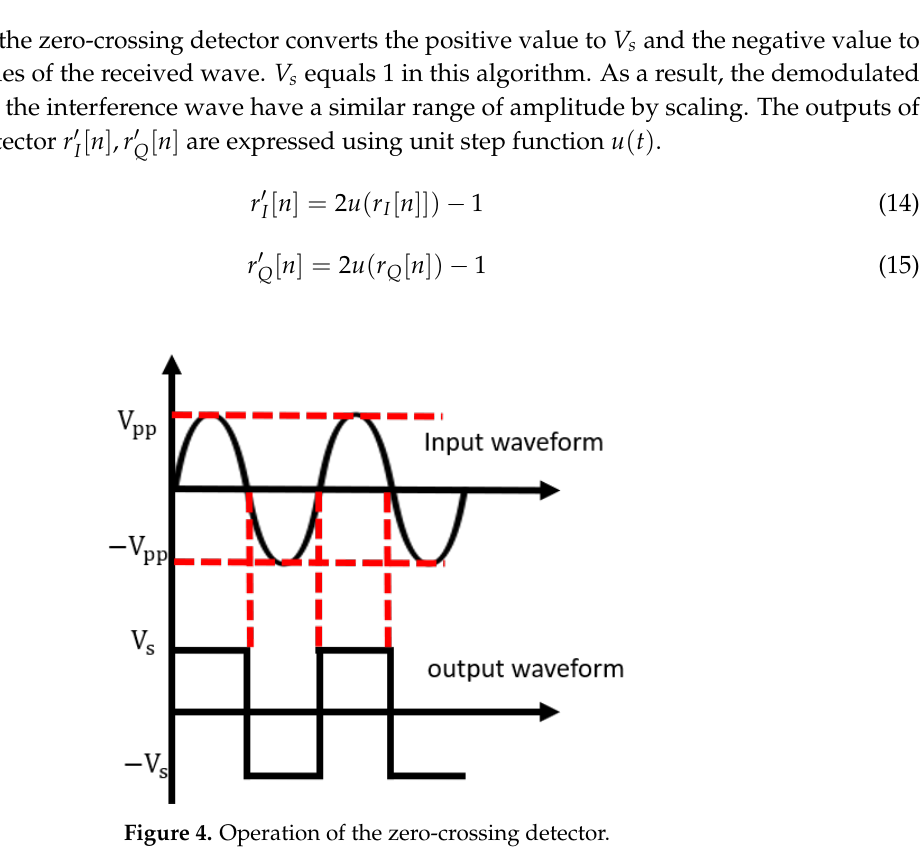
Figure 3. An example of the near–far problem.